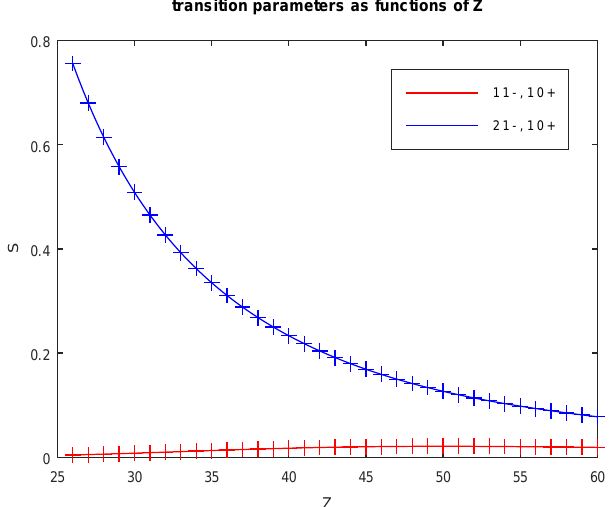
Figure 11. Fitted function to the line strength S for the transitions of 1 1 -, 2 1 - down to the 1 0 + groundstate. The m-file was edited, and we added the legend, see Section